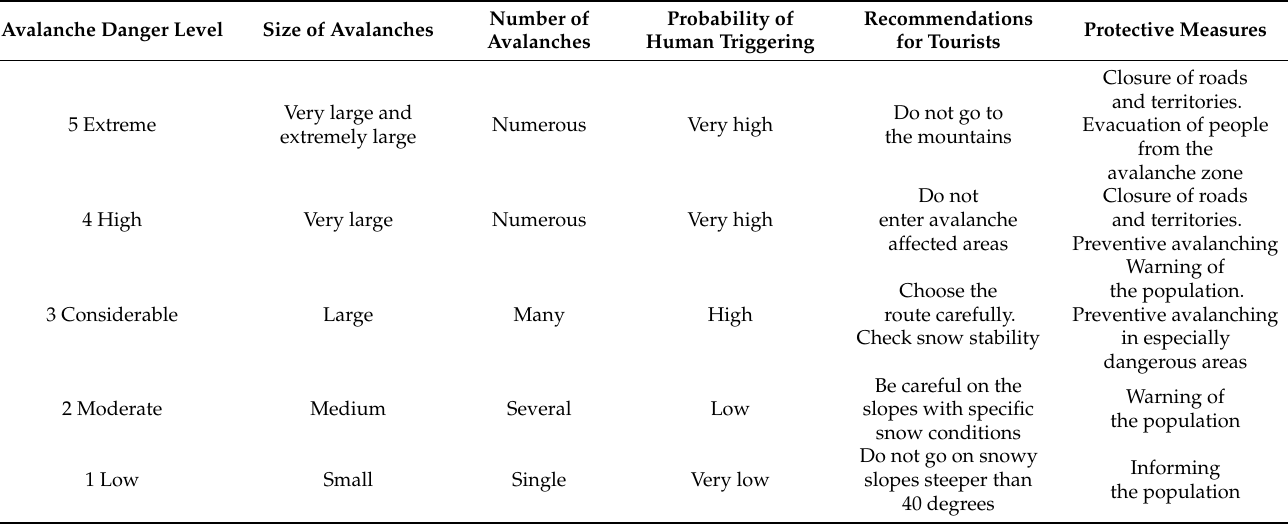
Table 2. The scale of avalanche danger